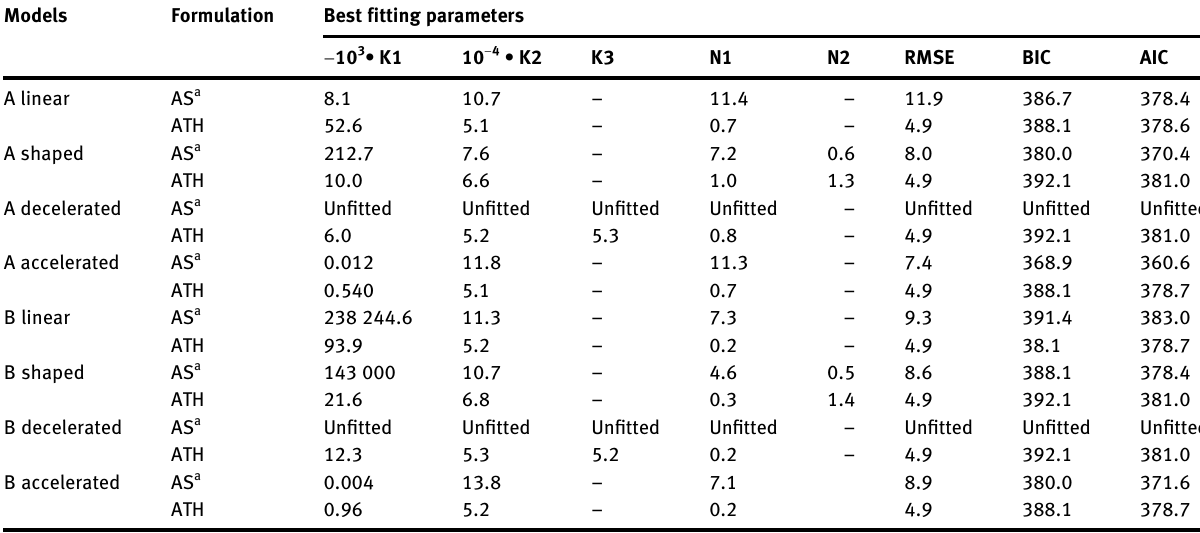
Table  : Modelling parameters calculated with “ R ” software.